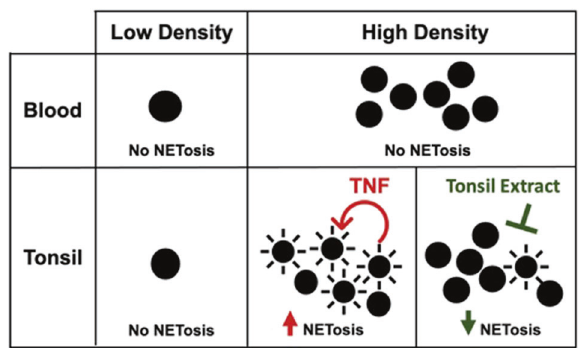
Fig. 6 Model of NETosis of tonsillar B cells. Tonsil but not PB B cells undergo NETosis at high cell density. The chromatin decondensa- tion in B cell NETosis is enhanced by B cell secretion of TNF. Treatment of B cells with tonsil tissue extract inhibits NETosis of tonsillar B